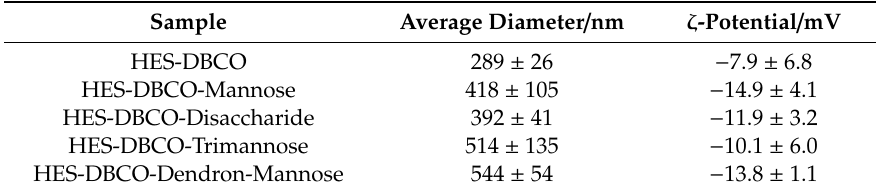
Table 1. Physicochemical properties of carbohydrate-modified HES nanocapsules. Average diameters were determined at a scattering angle of 90 ◦ .